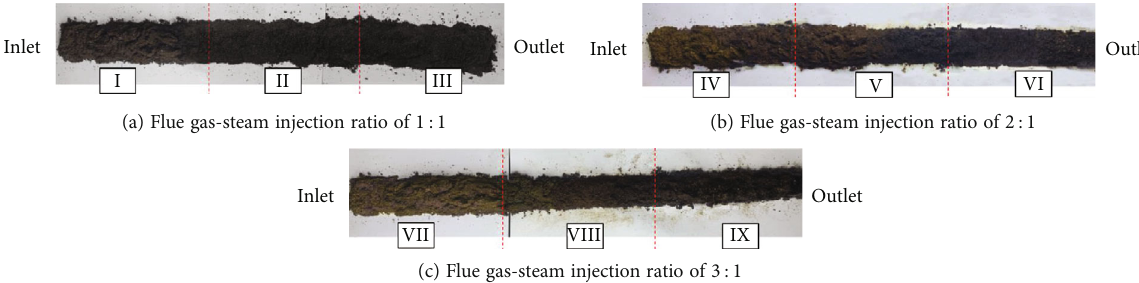
Figure 10: Distribution of oil sand in a one-dimensional sandpack under di ff erent injection ratios of fl ue gas to steam.